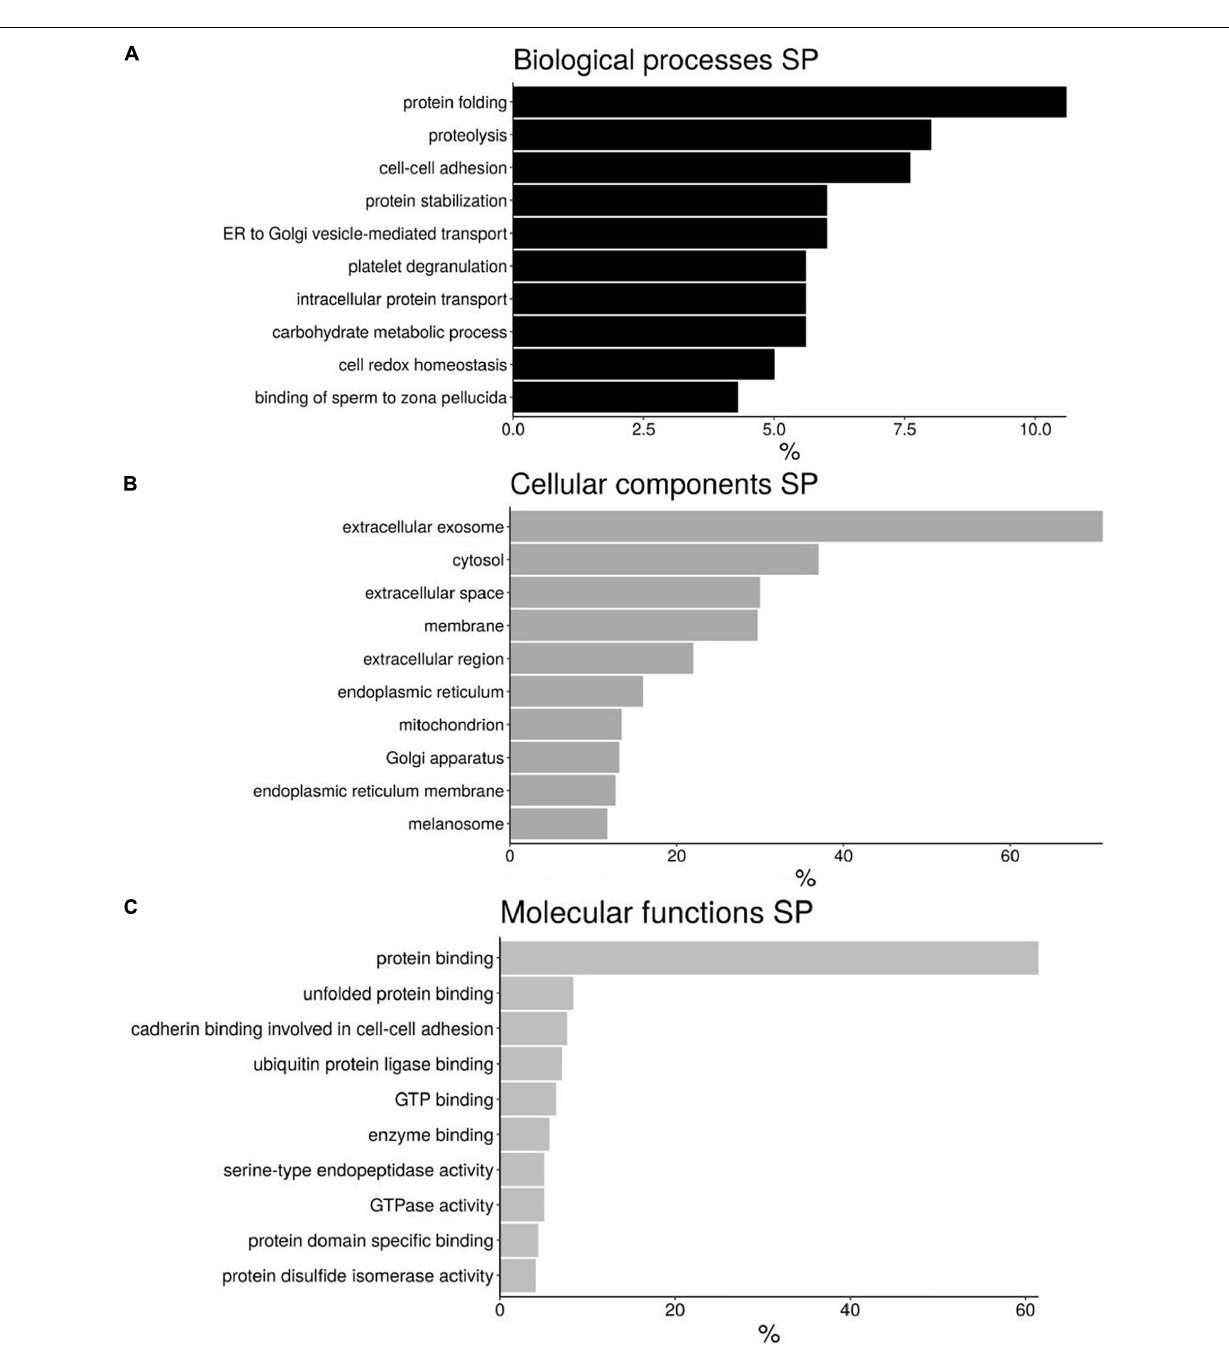
with light green for text mining, black for co-expression and blue for protein homology. Query proteins are represented as colored nodes and the second shell of interactors are represented as white nodes. Empty nodes represent proteins of unknown 3D structure and filled nodes represent predicted or known